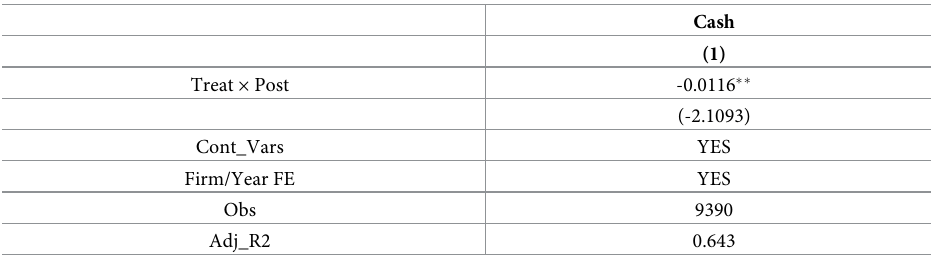
Table 5. Mechanism